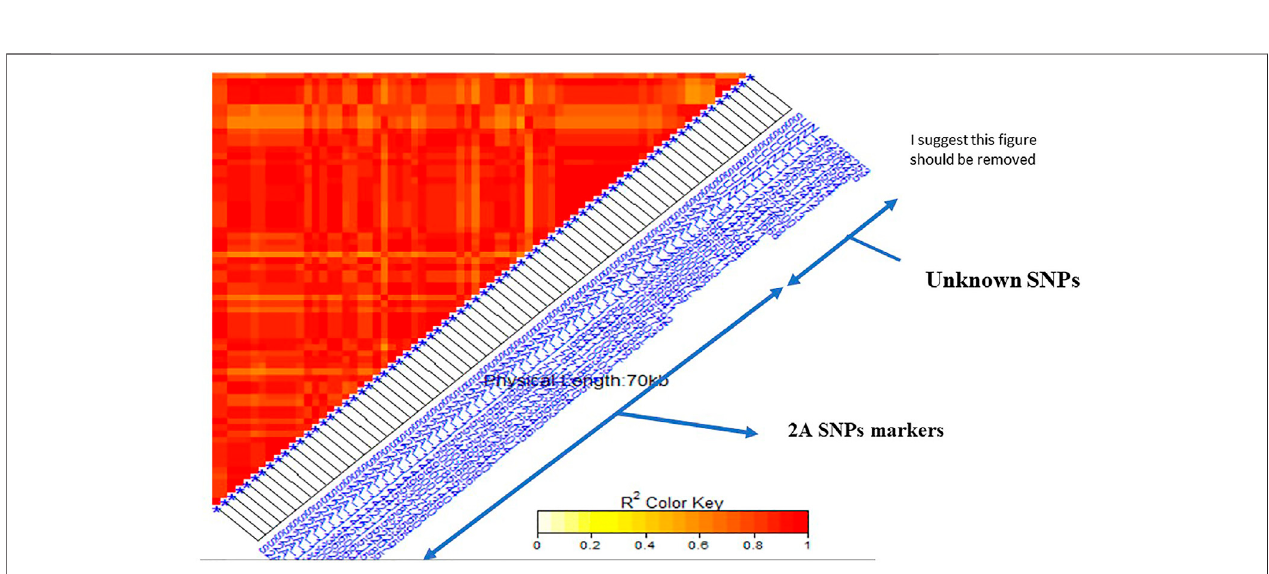
FIGURE 4 | Linkage disequilibrium (LD) analysis in the tested genotypes: heatmap of LD between the 59 SNPs located on 2A and 12 Unknown SNPs markers showed highly signi fi cant LD.